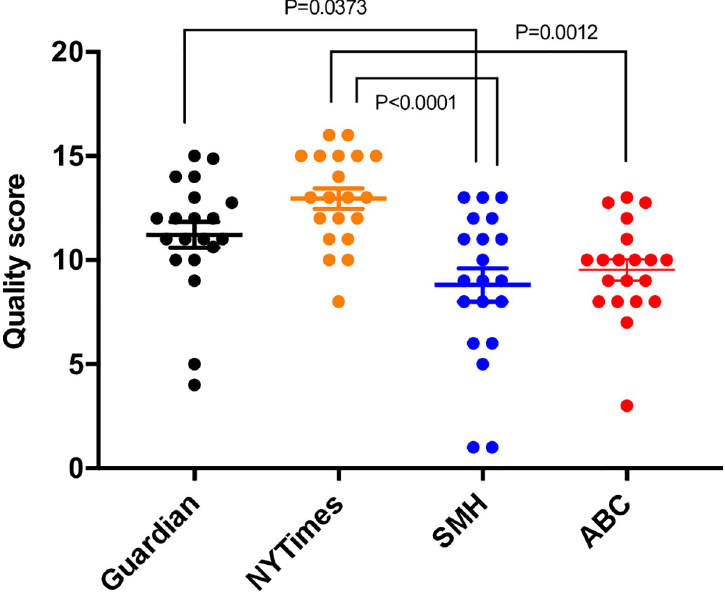
Fig 3. Quality scores of news reports on cancer research. Each point represents the score of an individual news report. Bars indicate the mean ± SEM for each news outlet (n = 20 for